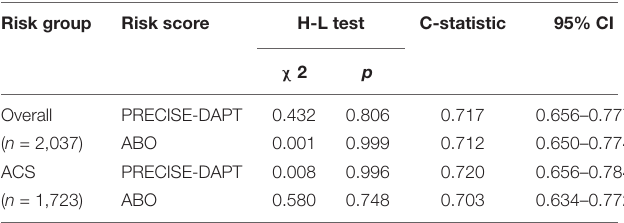
score (33.54 ± 14.33 vs. 23.23 ± 10.03, p < 0.001) than the patients in BARC < type 2 group.